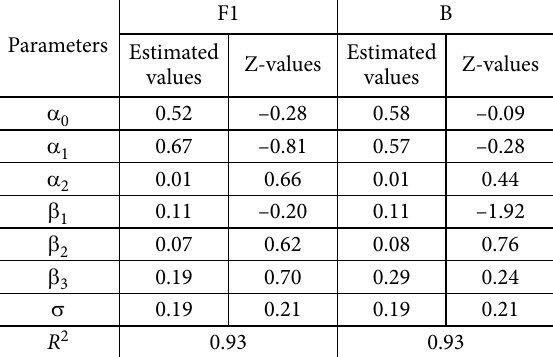
Table 1. Model estimation results for the increased time-trend